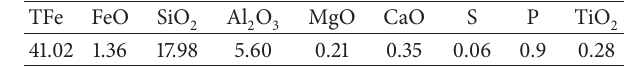
Table 1: Mineral composition of Huimin ore